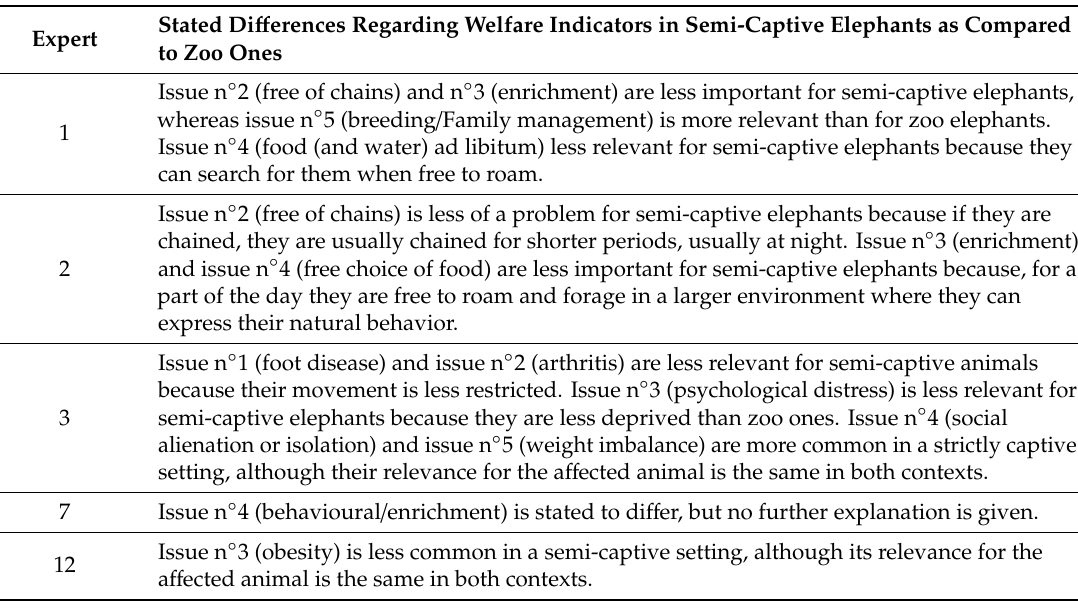
Table 2. Di ff erences stated by experts between zoo elephants and semi-captive ones regarding main welfare relevant